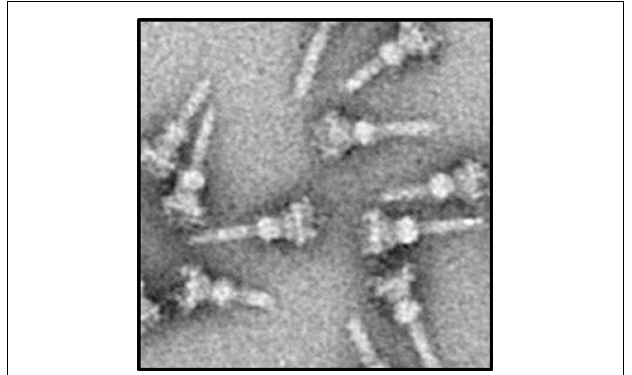
FIGURE 3 |A transmission electron-microscope image of isolatedT3SS needle complexes from S. typhimurium reproduced from Schraidt et al.